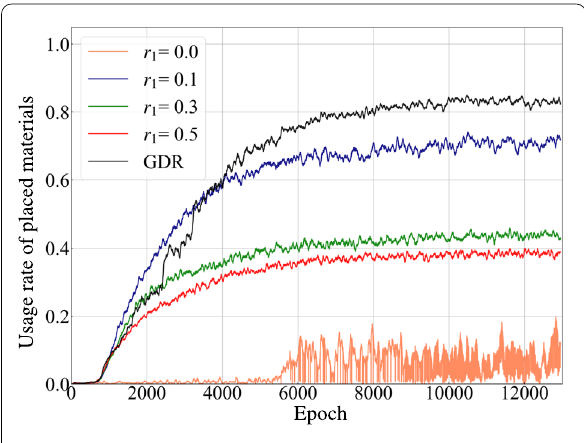
Figure 9 Usage rate of placed materials in Exp.